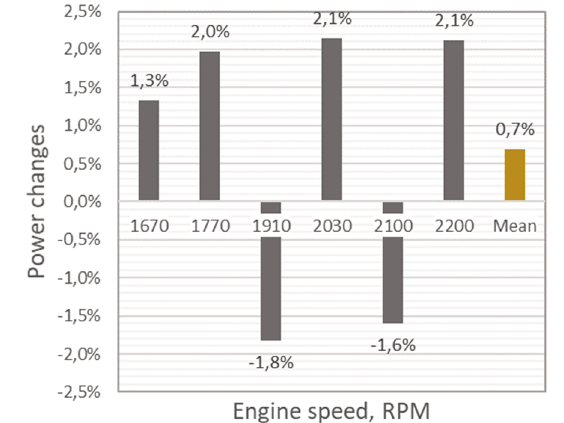
Fig. 4. Differences in reduced engine power between engines with constant and variable ignition advance angle